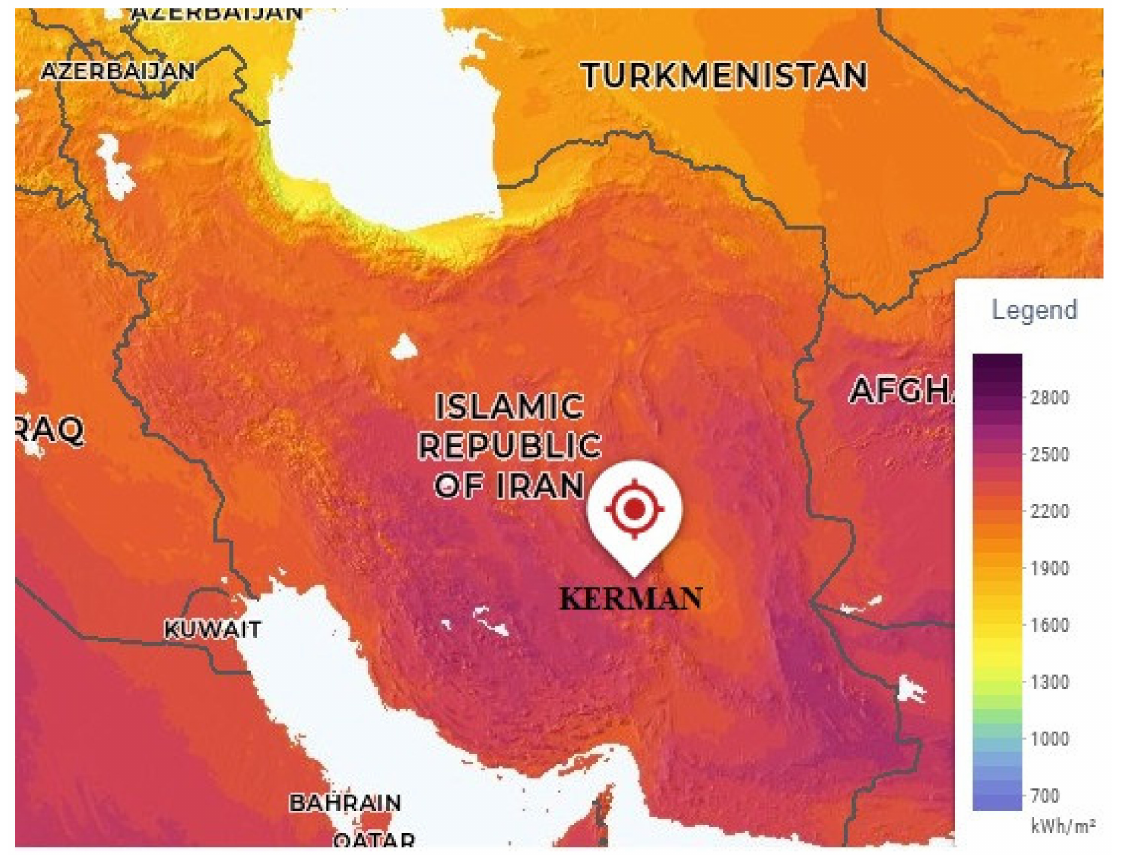
Figure 8. Map of annual, global, solar irradiation of Iran